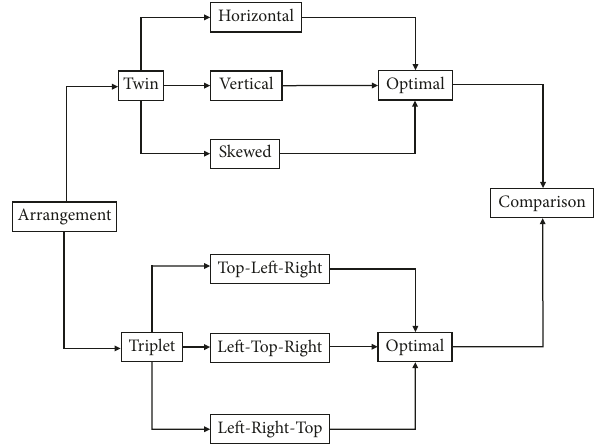
Figure 2: Flow chart showing the sequence of tunnels